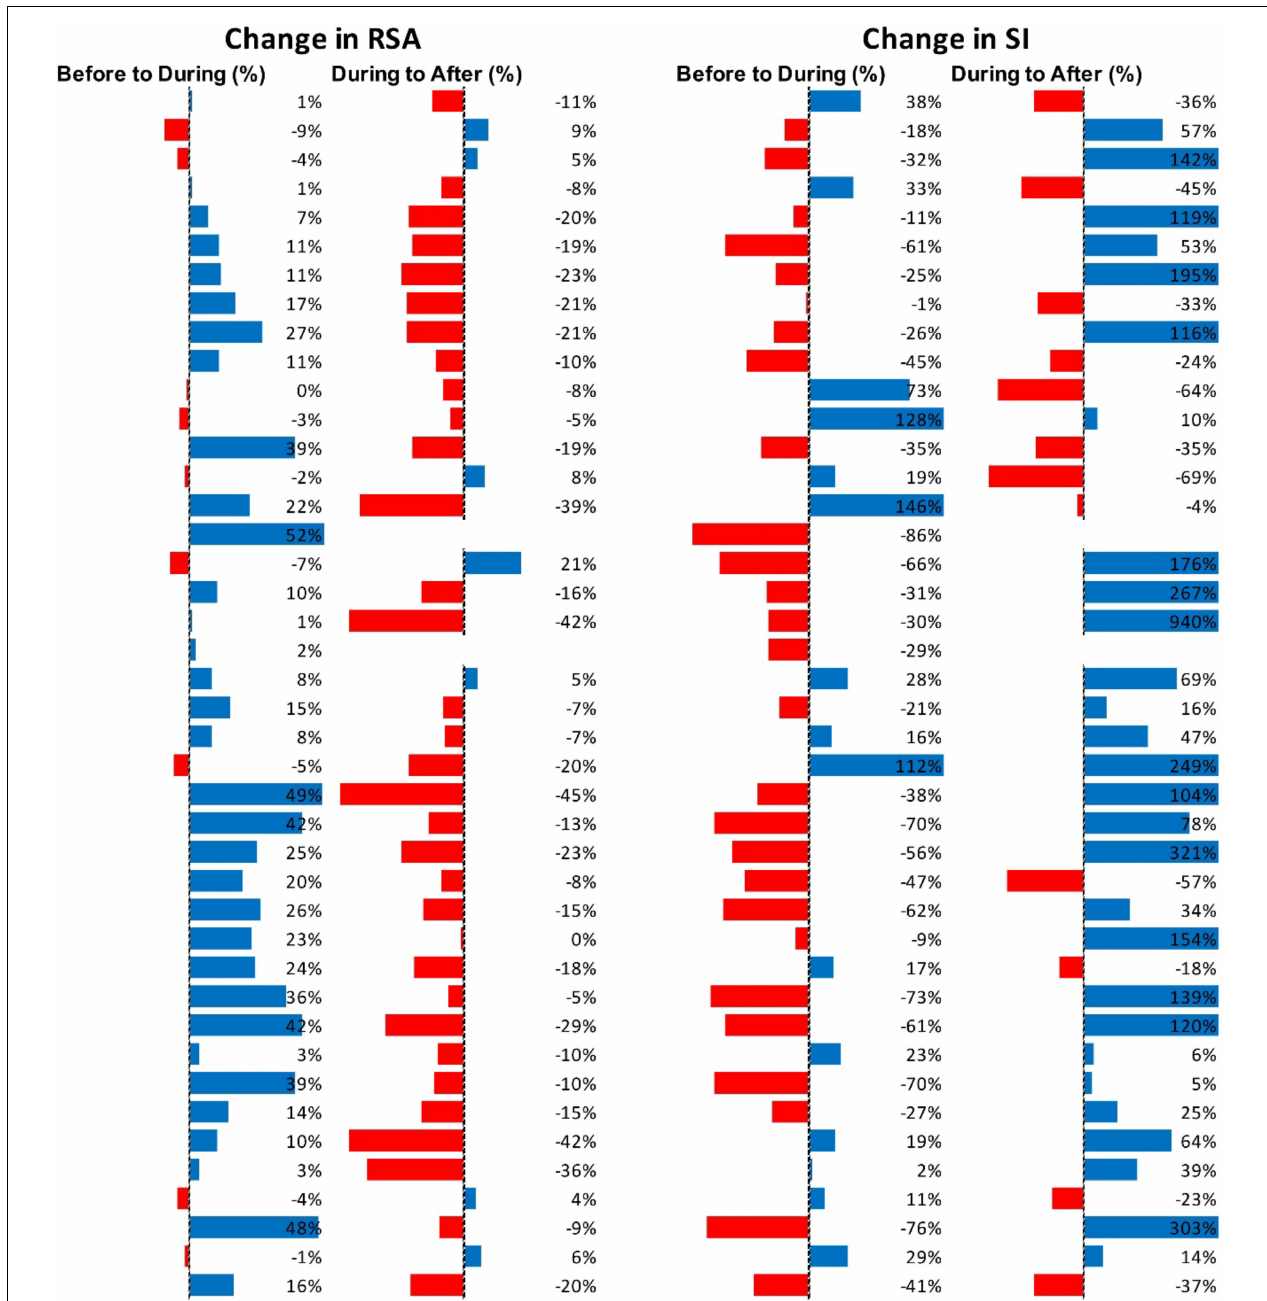
FIGURE 5 | Changes in autonomic activity in response to all individual Motor Complexes ( N = 42). Data are shown as% change. The Friedman test was applied for assessment of significance followed by Dunn’s multiple comparisons test. RSA: before to during p = 0.0007; during to recovery, p < 0.0001. SI: before to during p = 0.0104; during to recovery, p ≤ 0.0001